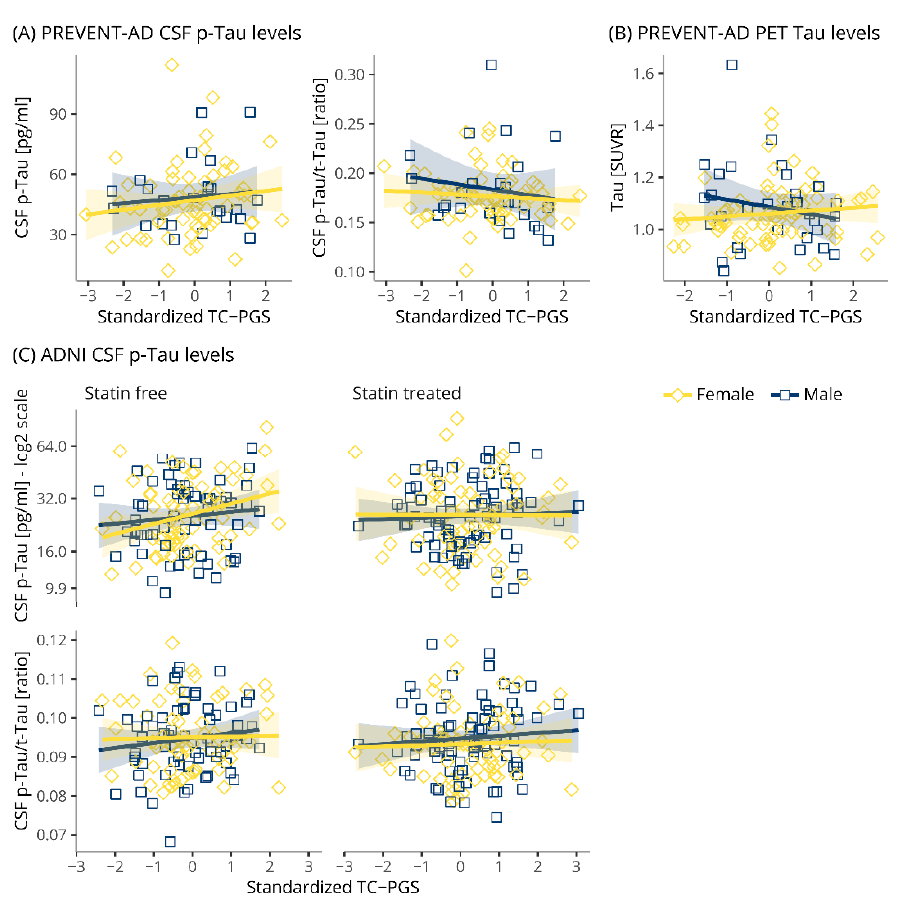
Figure 4. Associations of TC-PGS with biomarkers of TAU pathology. TAU pathology biomarkers plotted against TC-PGS and assessed by multiple linear regressions. ( A ) PREVENT-AD CSF levels of p-Tau and its ratio with t-Tau levels. ( B ) PREVENT-AD TAU brain levels, as assessed by PET. ( C ) ADNI CSF levels of p -Tau and its ratio with t-Tau. Shaded areas indicate 95% confidence intervals. Abbreviations: A β , amyloid- β ; CSF, cerebrospinal fluid; PET, p-Tau, phosphorylated TAU; t-Tau,